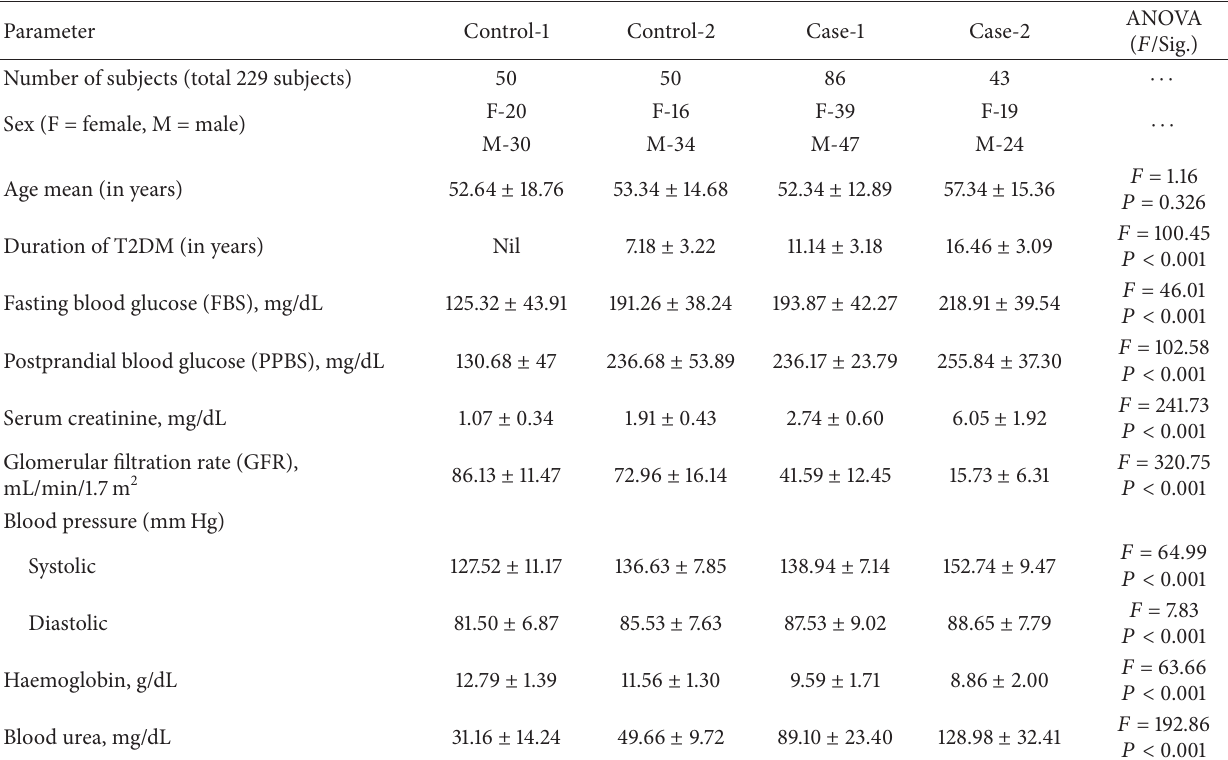
Table 1: Representation of clinical parameters and demography for controls and